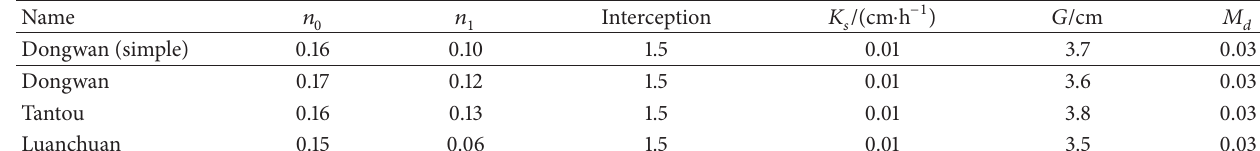
Table 6: Parameters and initial values of nested catchment.